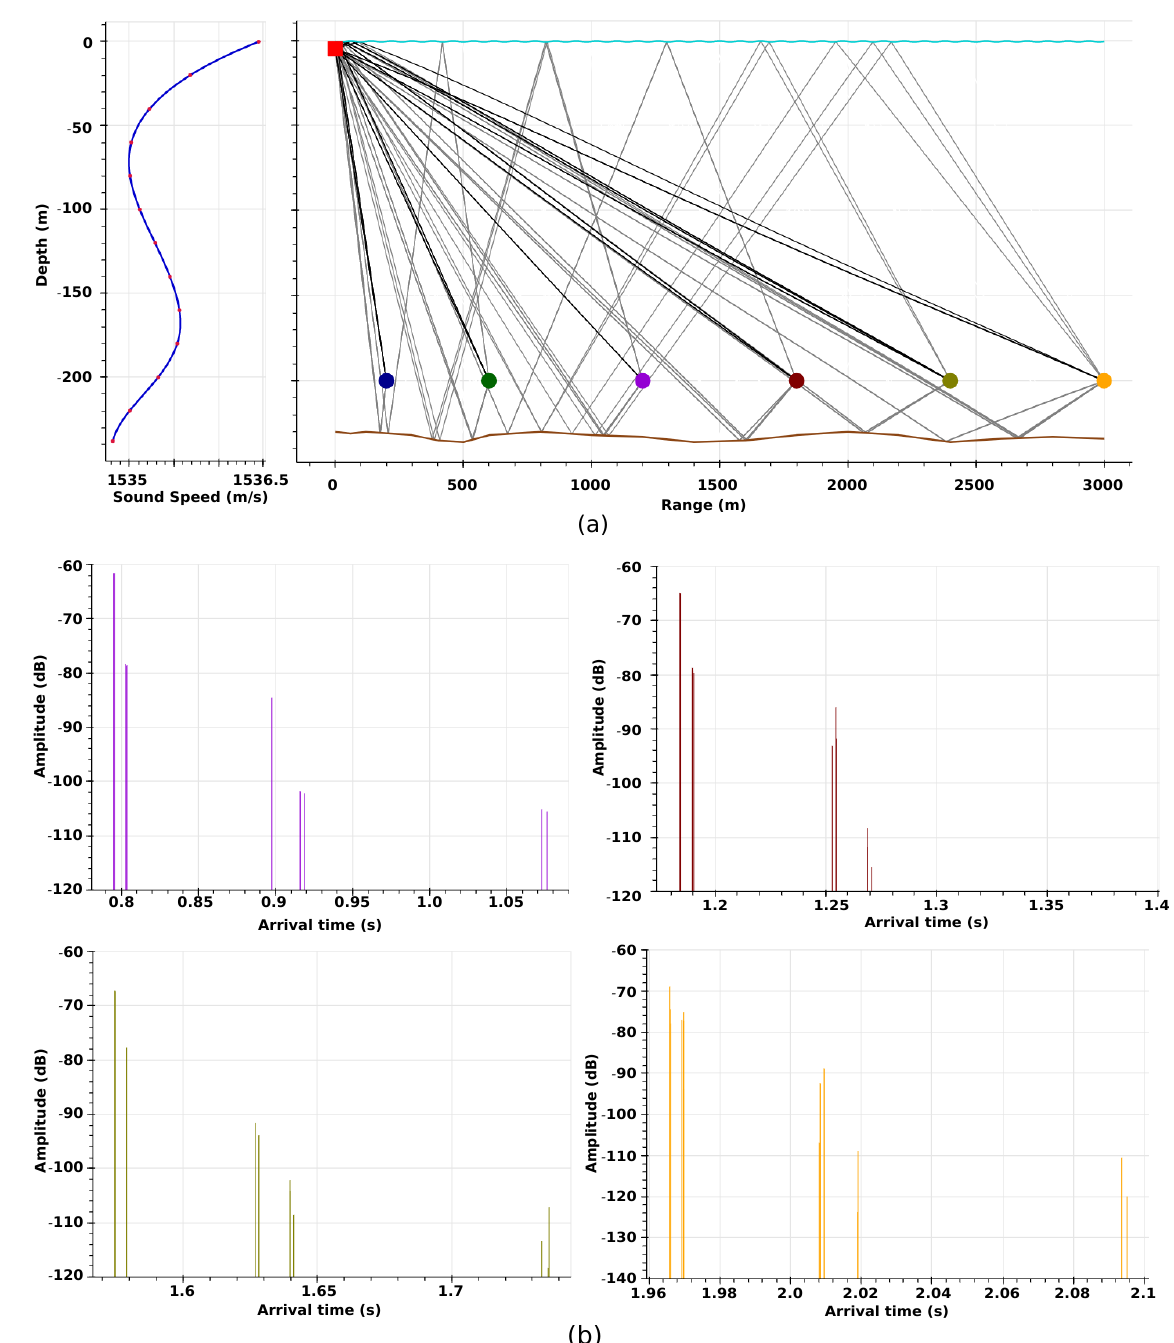
Figure A2. Multipath propagation of acoustic in moderately deep sea. The simulation parameters are similar to the one in Figure A1 except the receivers are at depth of 200 m and the seabed is at ≈ 220